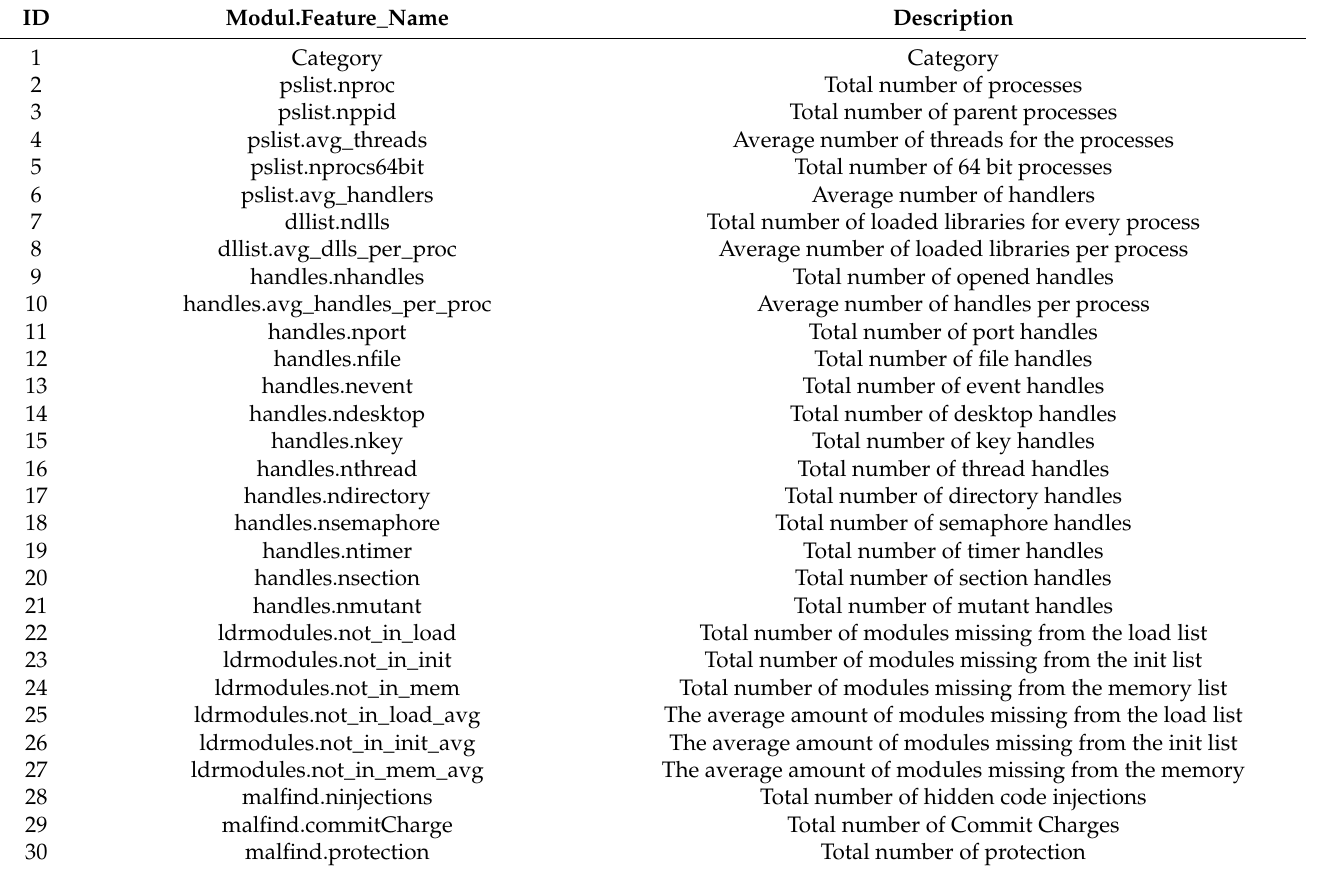
Table 2. Detailed explanation of the attributes of the CIC-MalMem-2022